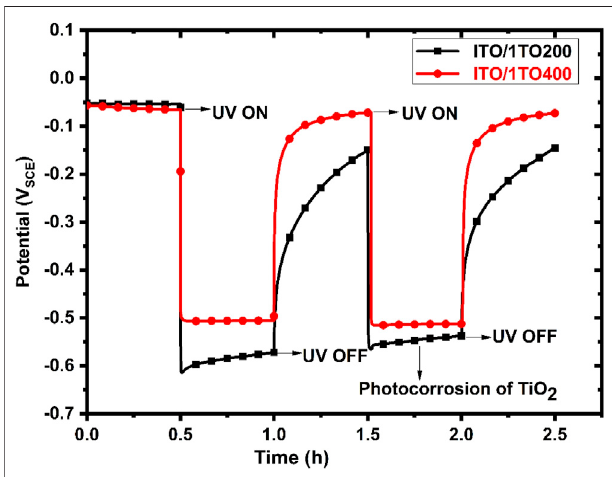
FIGURE 8 | OCP responses of ITO/1TO400 and ITO/1TO200 in the designated electrolyte solution to the absence and presence of UV illumination.